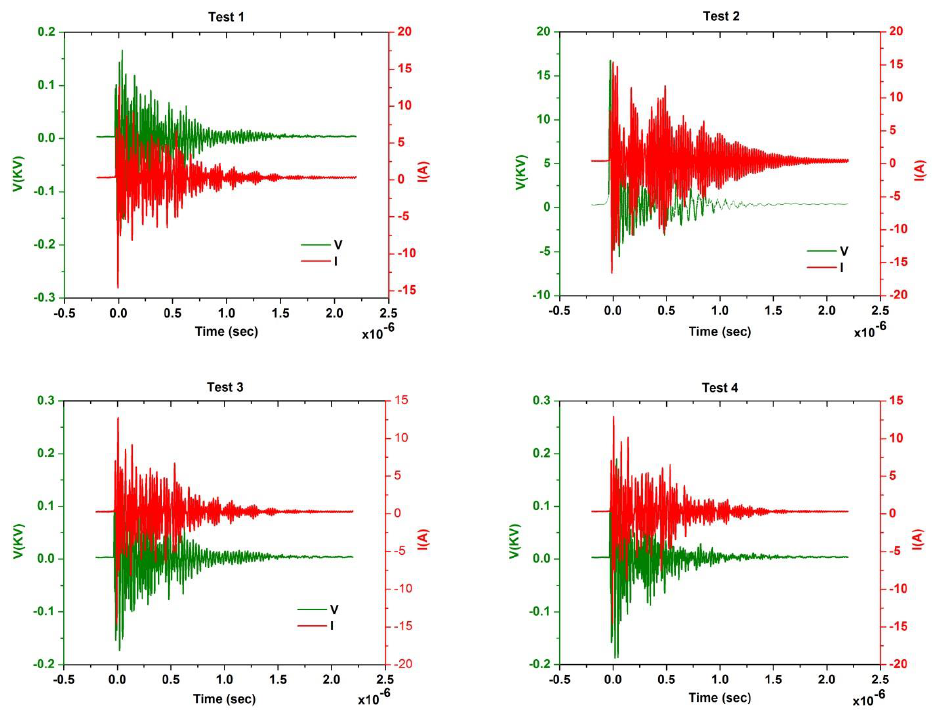
Figure 4. Voltage V(t) and current I(t) characteristics at different percentage of applied voltage and standoff distances.